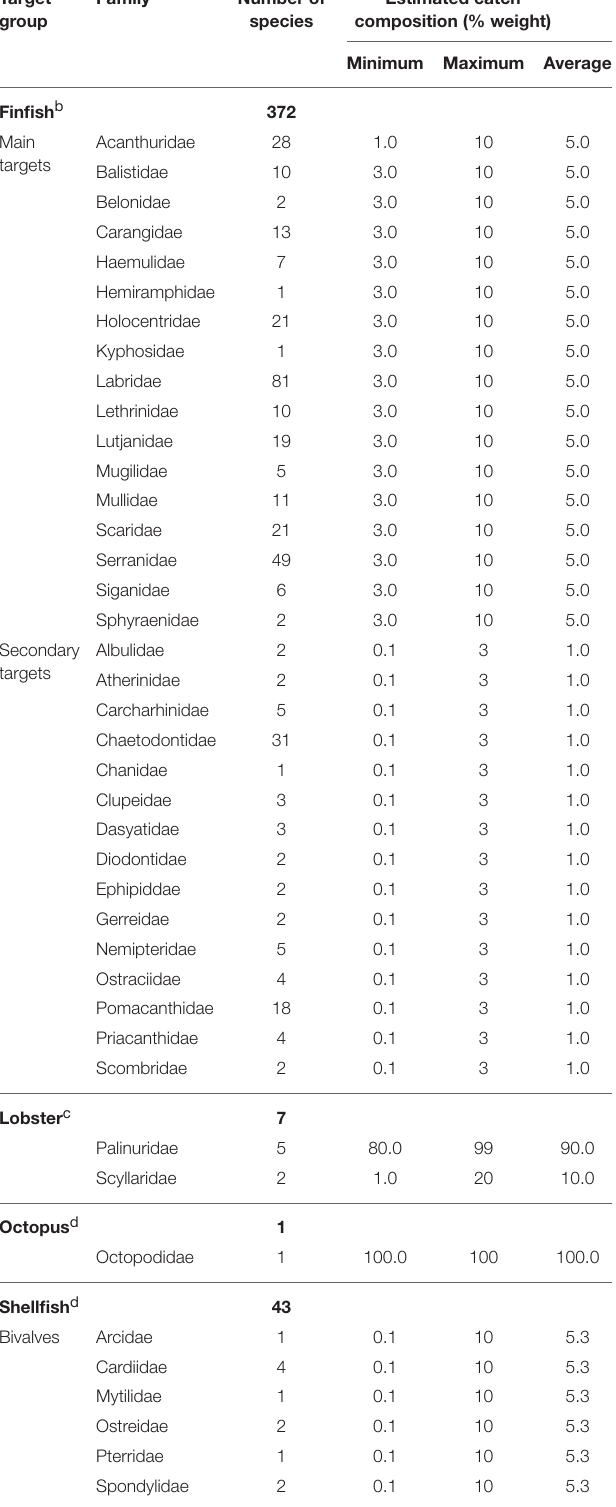
TABLE 3 | Derived taxonomic composition of the finfish, lobster, octopus, and shellfish catches for the shallow water fisheries in Vanuatu, 1950–2014. Target